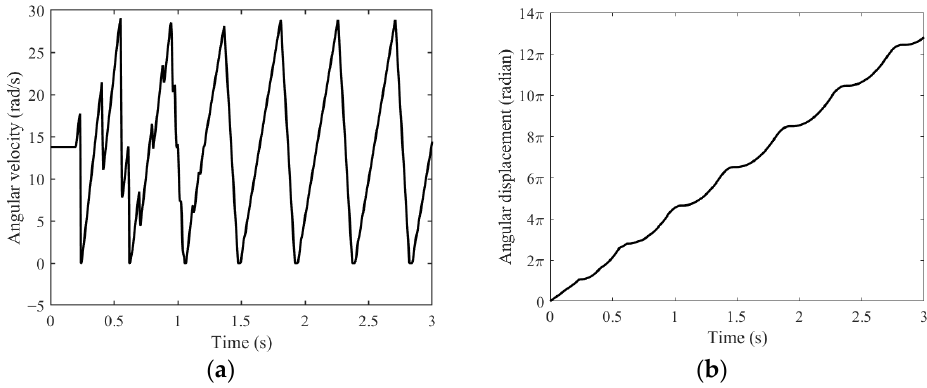
Figure 18. Dynamic features of output shaft under continuous closing. ( a ) Angular velocity. ( b ) An- gular displacement.